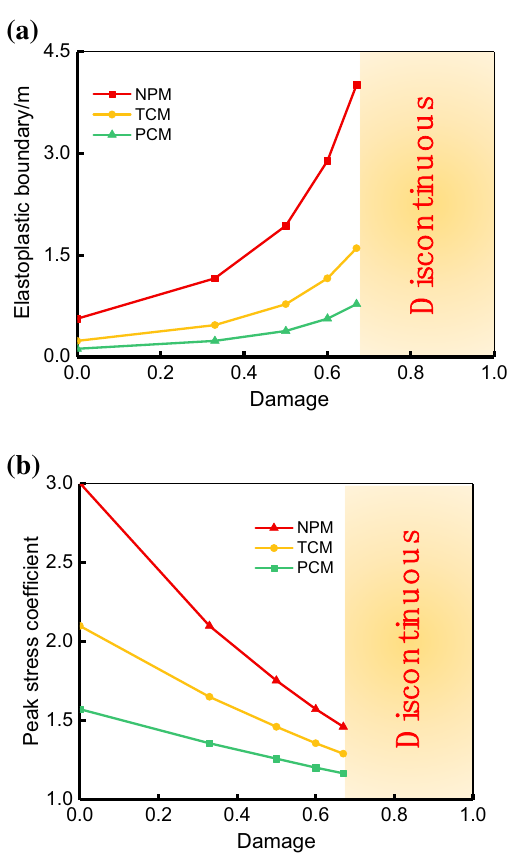
Fig. 4 Plastic zone with increasing damage of a elastoplastic boundary and b peak stress